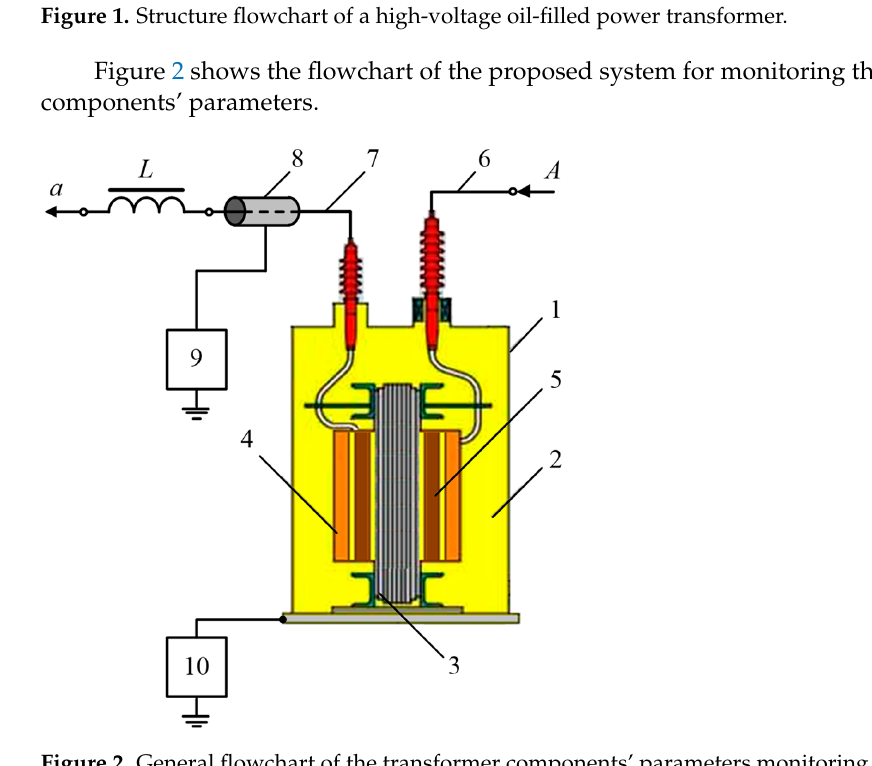
Figure 2. General flowchart of the transformer components’ parameters monitoring system.